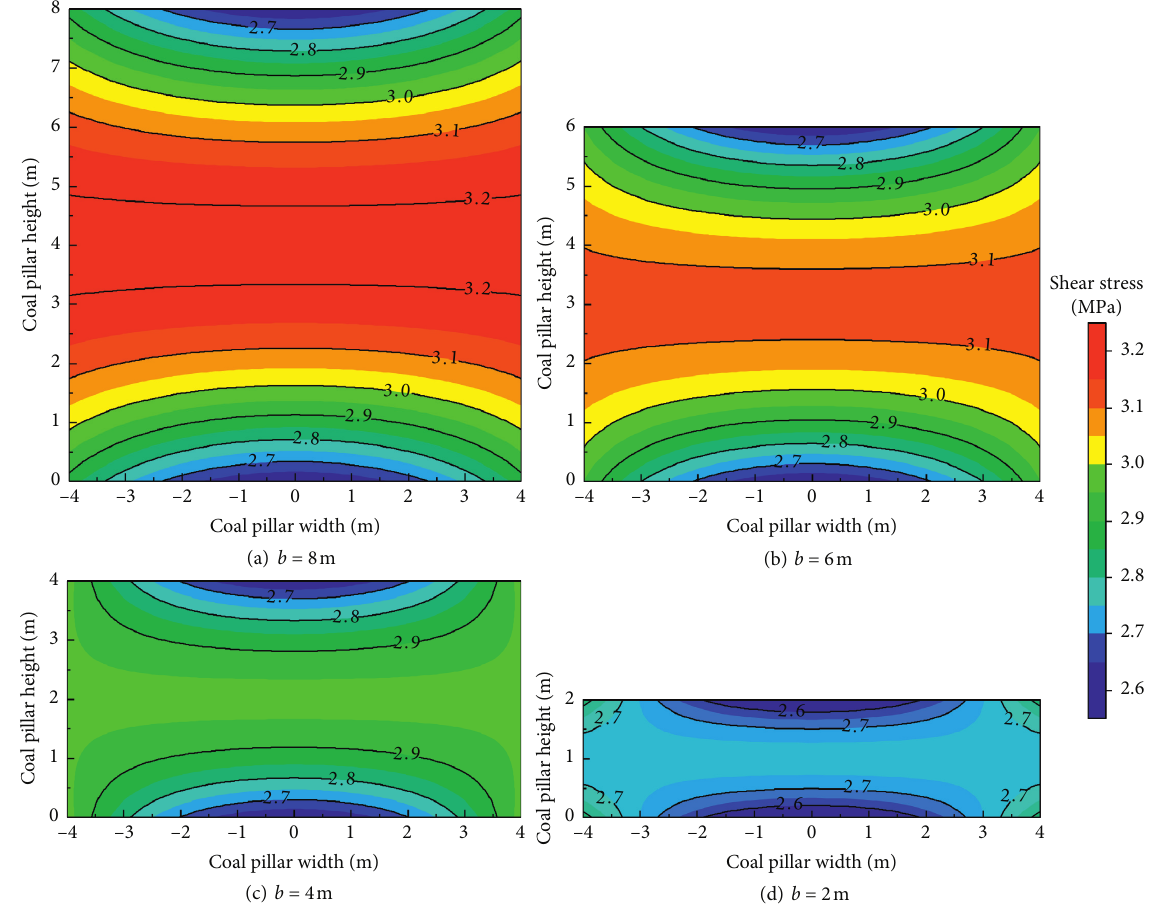
Figure 4: Shear stress distribution in different heights of coal